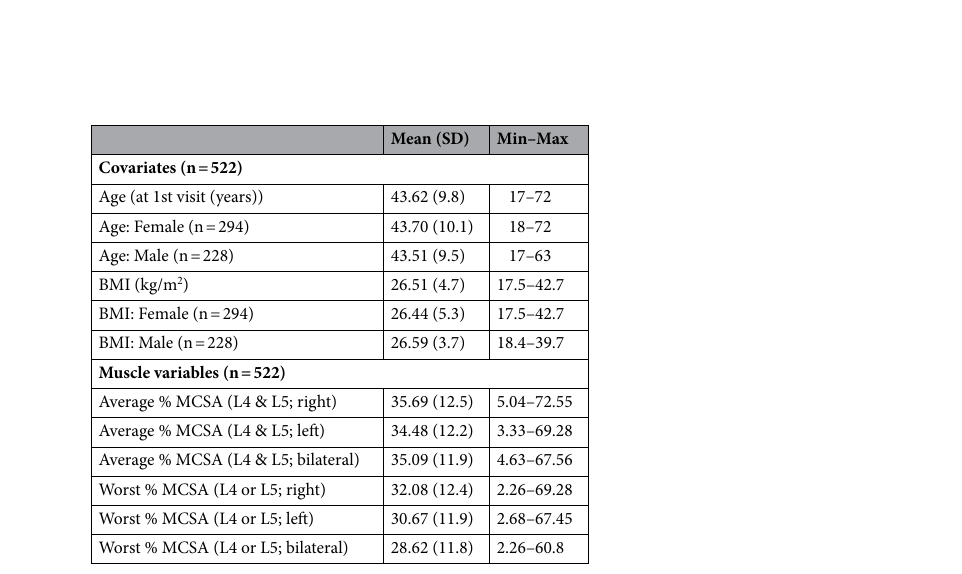
Table 2. Descriptive statistics. % MCSA, proportion of peak muscle cross-sectional area; SD, standard